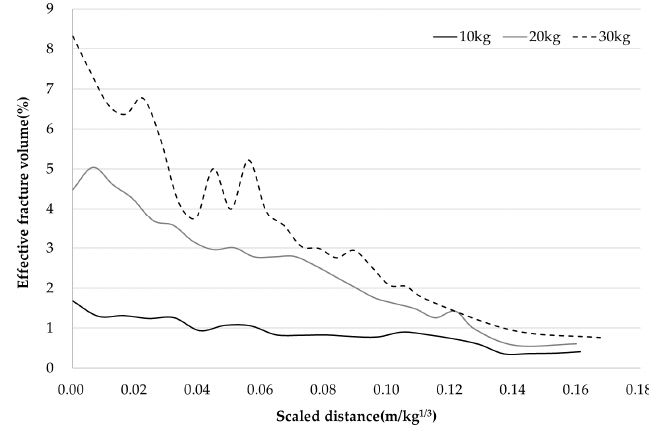
Figure 7. E ff ective fracture Figure 7. Effective fracture volume.